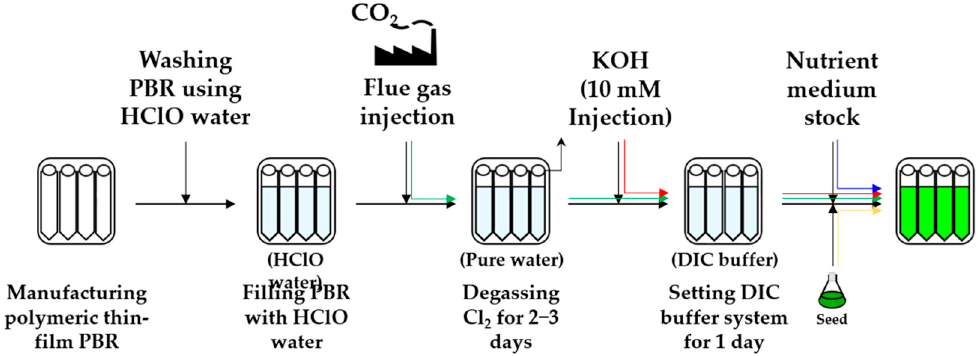
Figure 1. Overall process scheme for mass cultivation of microalgae without microbial contamination.